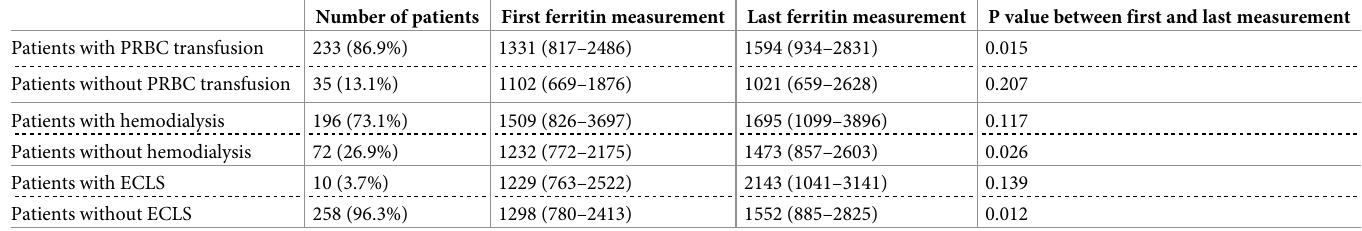
Table 2. First and last ferritin measurement between different groups.